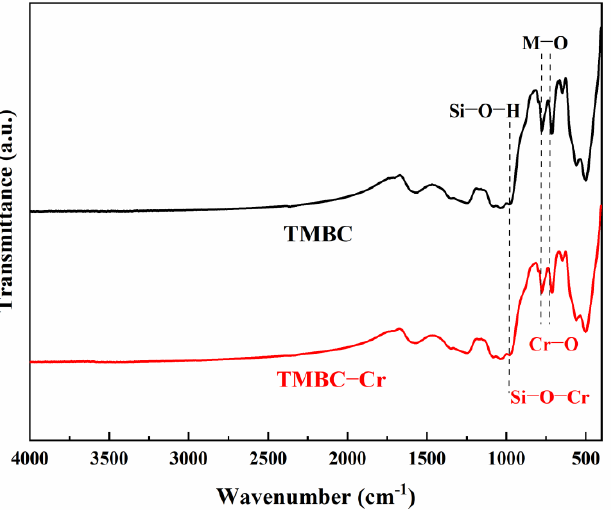
Figure 7. FTIR spectrum of TMBC before and after adsorption of Cr (VI).